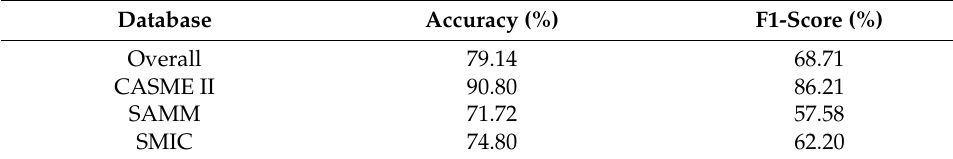
Table 8. OC-Net with data augmentation for ME